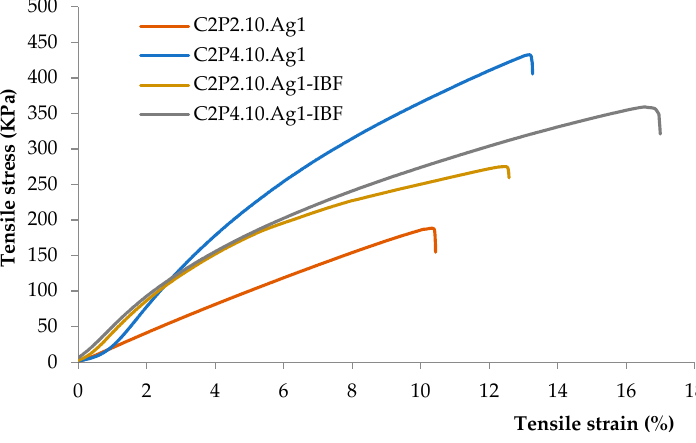
Figure 7. Stress-strain curves for series C2P2.10.Ag1 and C2P4.10.Ag1.